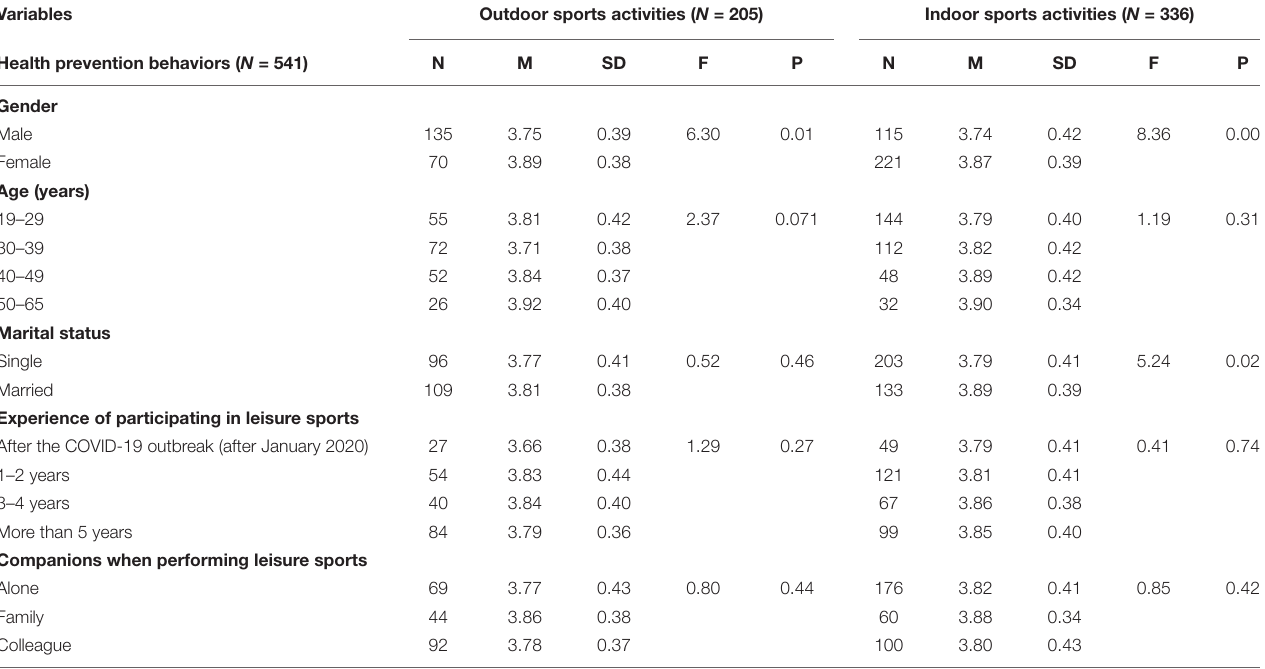
TABLE 3 | Differences in adoption of preventive health behaviors in terms of demographic characteristics. Variables